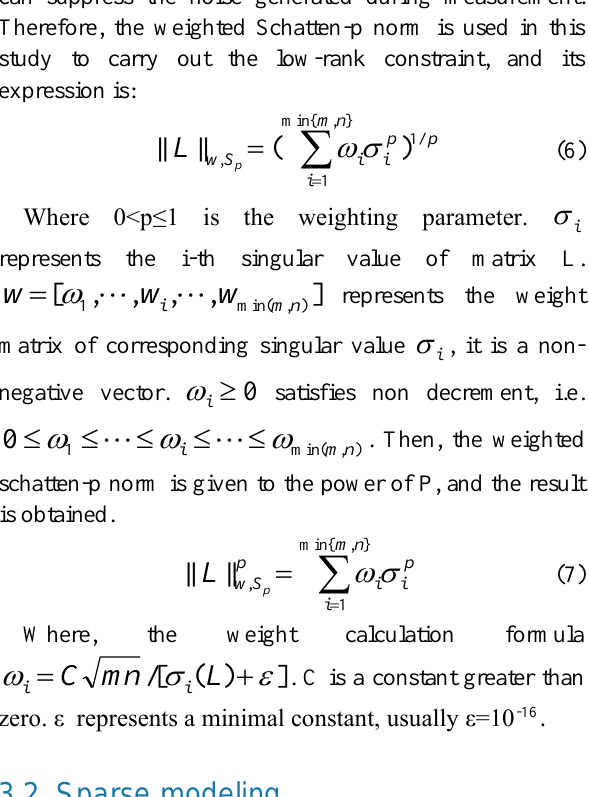
Figure 4. sub-block division of